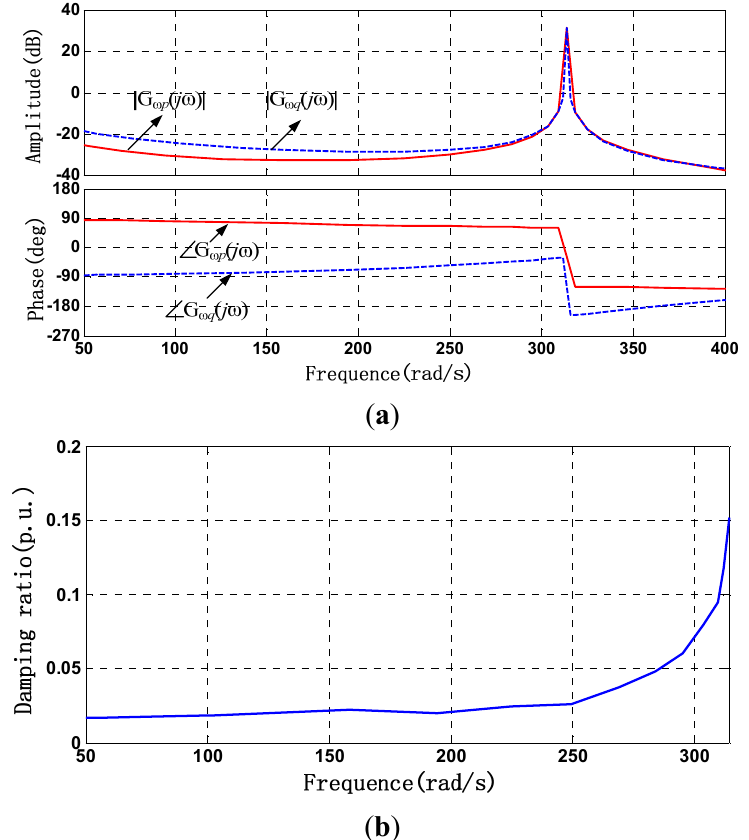
Figure 5. Characteristics of the transfer function without auxiliary damping control, ( a ) amplitude-frequency and phase-frequency characteristic curve; ( b ) Damping ratio